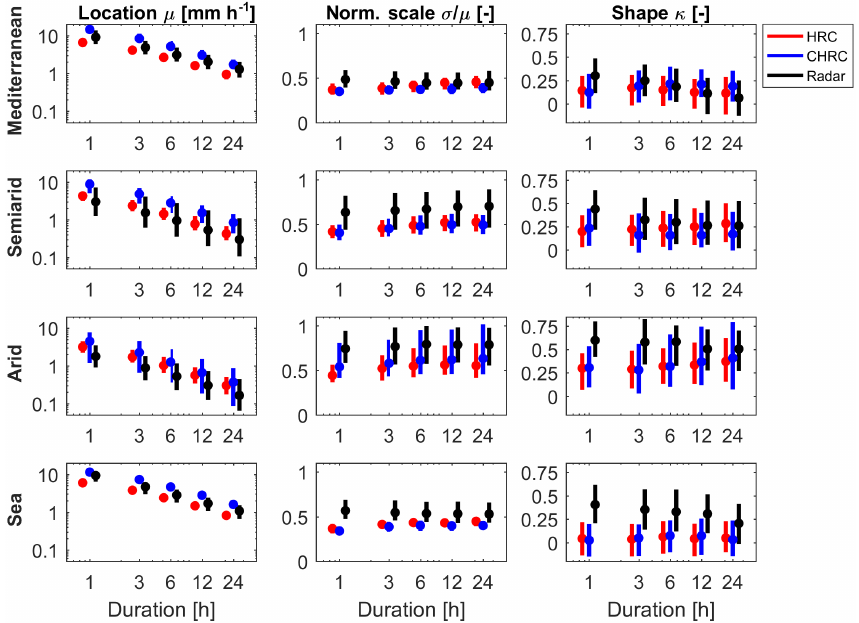
Figure 2. Distribution (median and 25–75th quantiles) of the GEV parameters derived from satellite (HRC and CHRC) and radar datasets. Note that scale parameters are normalized over the corresponding location parameters. The parameters for different products are represented around the corresponding duration; therefore, the logarithmic scale in the x axes should be interpreted